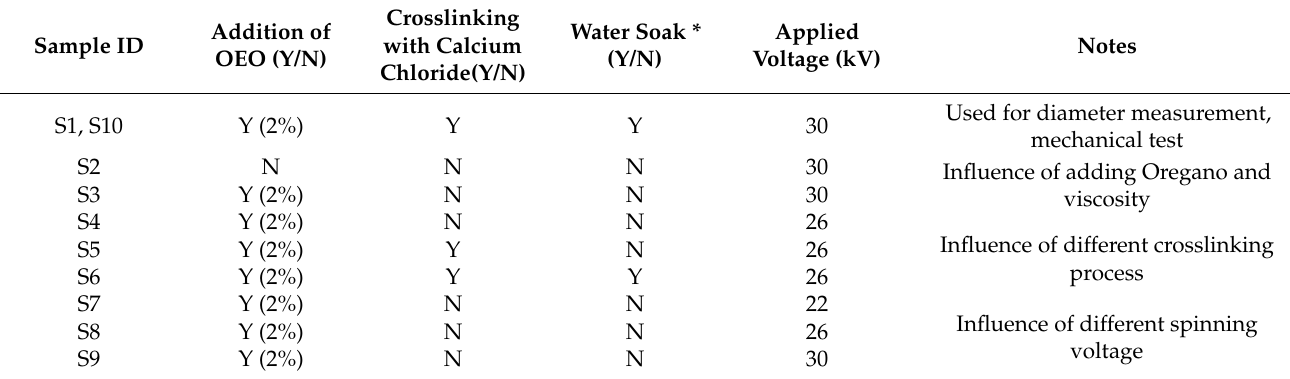
Table 1. Samples produced: preparation of solution for electrospinning and manufacturing process parameters.